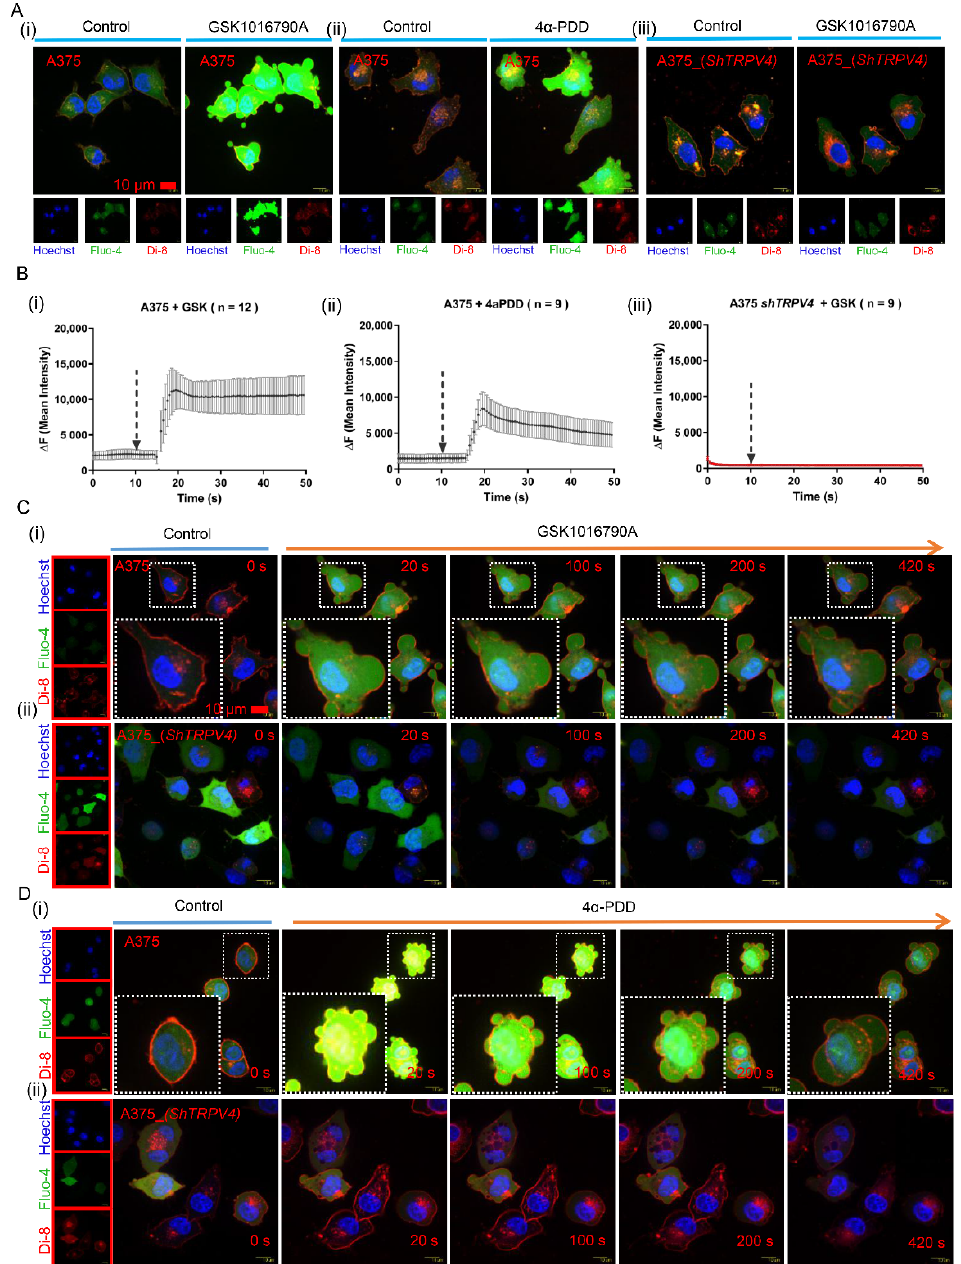
Figure 1. Activation of TRPV4 triggers exocytosis via agonist stimuli. ( A ) Representative scanning disk confocal images of agonists with ( i ) GSK1016790A (20 nM) or ( ii ) 4 α‐ PDD (5 μ M) stimuli to A375 cells and ( iii ) A375 cells with TRPV4 knock ‐ down. Fluorescence stained for nucleus (blue, hoechst 33342, 5 μ g/mL), intracellular calcium (green, Fluo ‐ 4, AM, 1.25 μ M), and plasma membrane (red, Di ‐ 8 ANEPPS, 10 μ M). Scale bar, 10 μ m. ( B ) Calcium imaging for agonists stimuli of TRPV4 by ( i ) GSK1016790A (20 nM), as well as ( ii ) 4 α‐ PDD (5 μ M) in human A375 melanoma cells and ( iii ) A375 cells with TRPV4 knock ‐ down. ( C ) Time ‐ lapse of scanning disk confocal images of ( i ) A375 cells and ( ii ) controlled A375 cells with TRPV4 knock ‐ down at indicated time points after GSK1016790A (20 nM) administration. ( D ) Time ‐ lapse of scanning disk confocal images of ( i ) A375 cells and ( ii ) A375 cells with TRPV4 knock ‐ down after 4 α‐ PDD (5 μ M) administration.